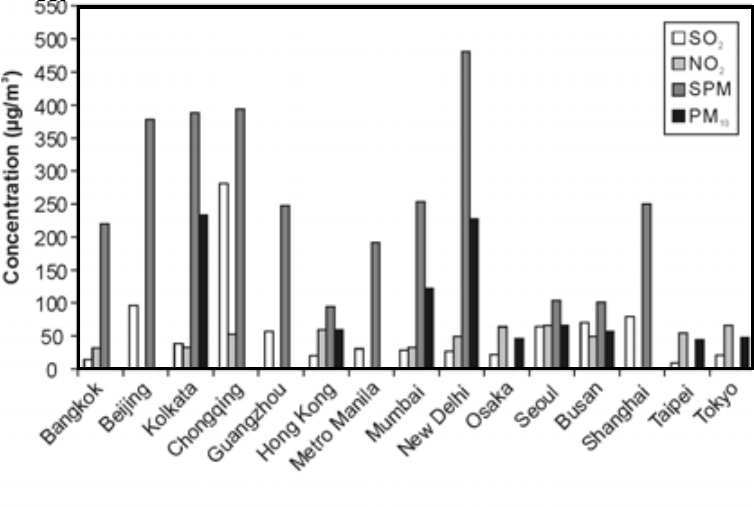
Figure 6. Average annual pollution concentrations by